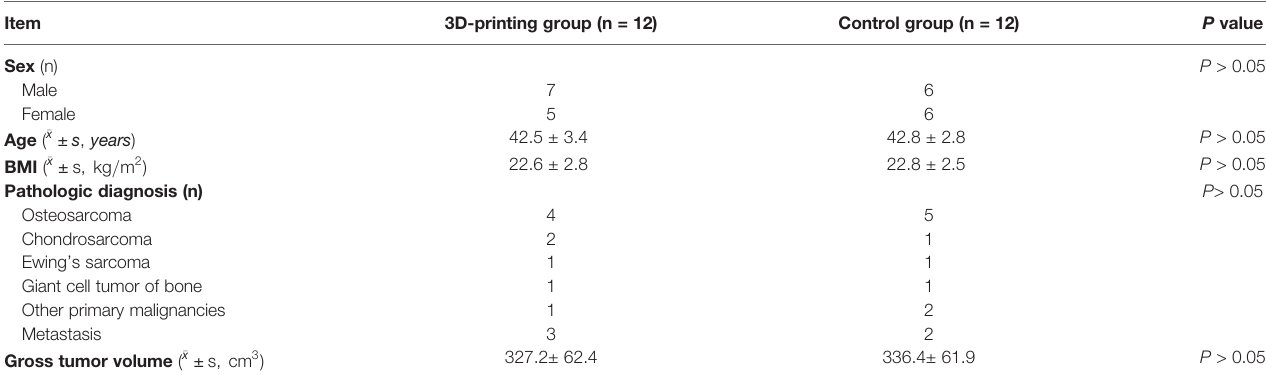
TABLE 1 | Baseline data of patients with sacroiliac joint tumor resection and